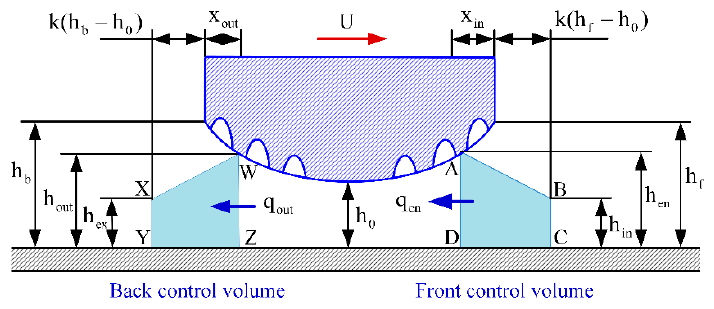
Figure 3. Schematic diagram of lubrication condition: ( a ) Fully flooded lubrication condition; ( b ) Starved lubrication condition.